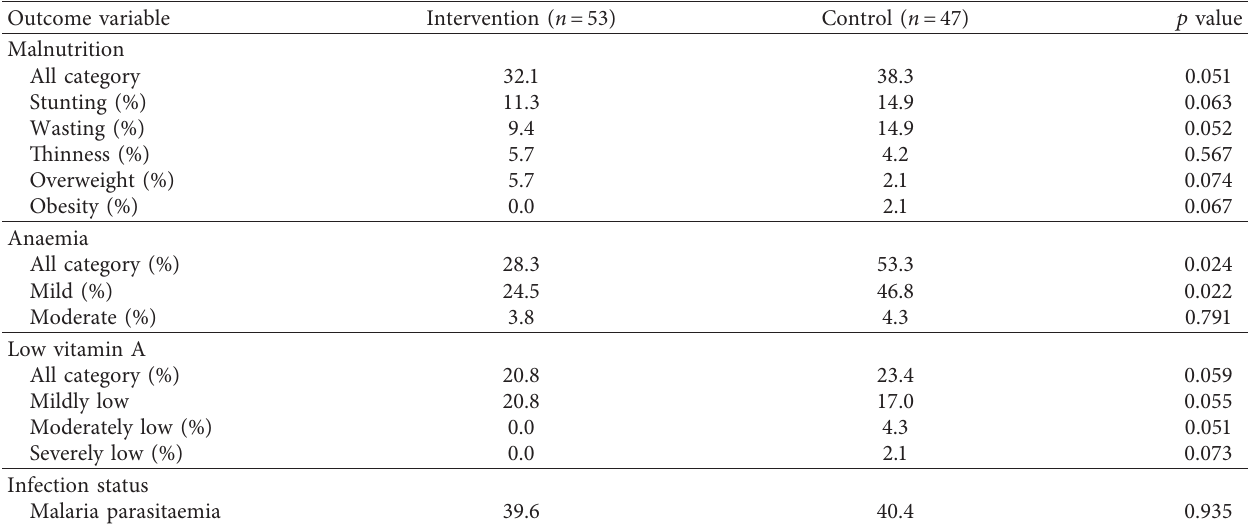
Table 5: Nutritional and infection status of study participants at the end of the